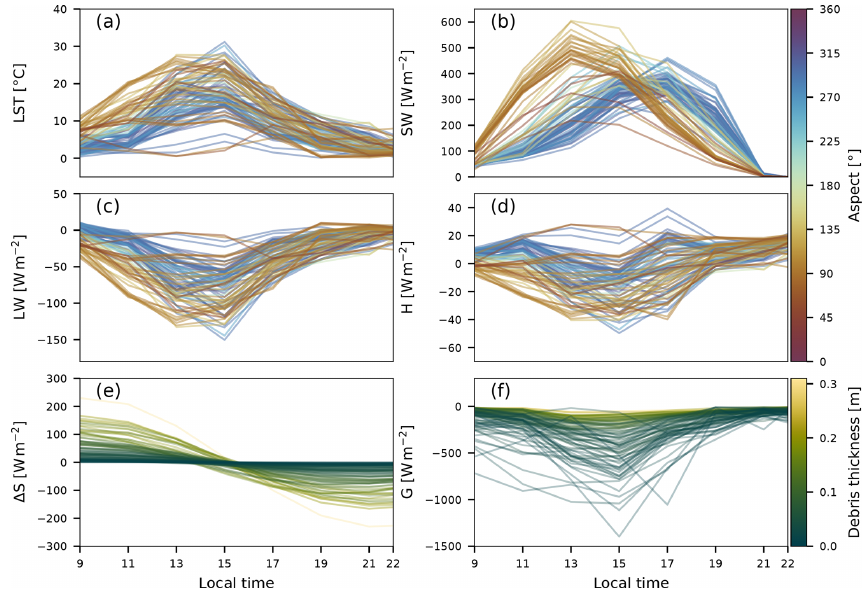
Figure 6. Energy fluxes at debris-thickness measurement locations. Diurnal variations of (a) land surface temperature, LST; (b) net shortwave radiation, SW; (c) net longwave radiation, LW,; and (d) sensible heat flux, H , with lines colorized by terrain aspect with 0 / 360 ◦ facing north. Diurnal variations of (e) the change in heat storage, (cid:49)S , and (f) the conductive heat flux, G , with lines colorized by debris thickness measured in the field. Note that only SW (b) is independent of LSTs, whereas data in panels (c–f) are a function of LSTs. Table 3. ERA5-Land hourly reanalysis data on 30 August 2019 interpolated at the Tsijiore Nouve Glacier, Switzerland (46.01 ◦ N, 7.46 ◦ E). Local flight Incoming longwave Wind speed, Air